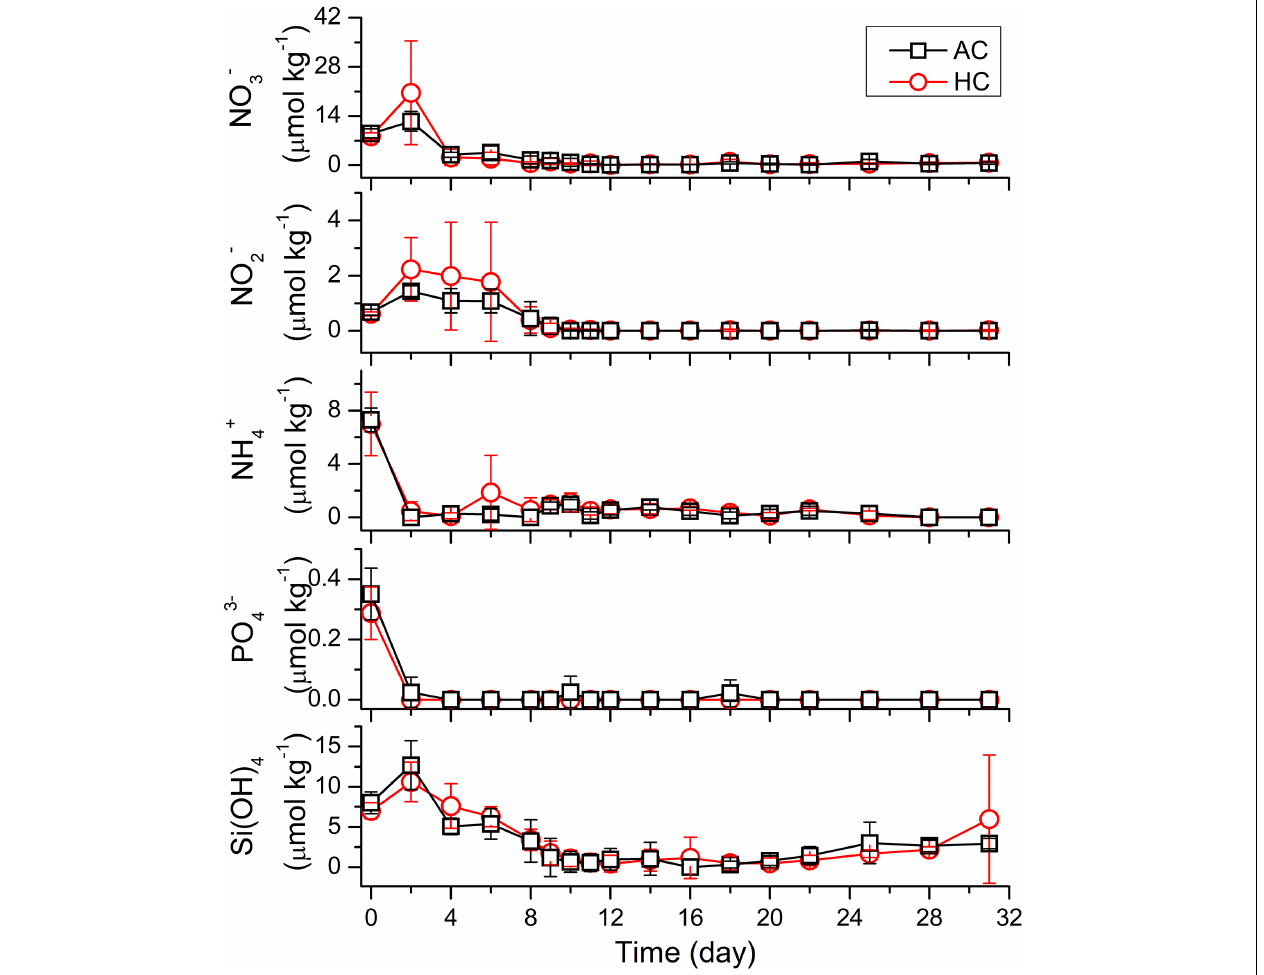
FIGURE 2 | Temporal variations of nutrients (NO 3 − , NO 2 − NH 4 + , PO 43 − , and Si(OH) 4 ) in HC (1000 ppmv) and AC ( ∼ 410 ppmv) treatments. Data are means ± SD of replicates for HC treatments and for AC